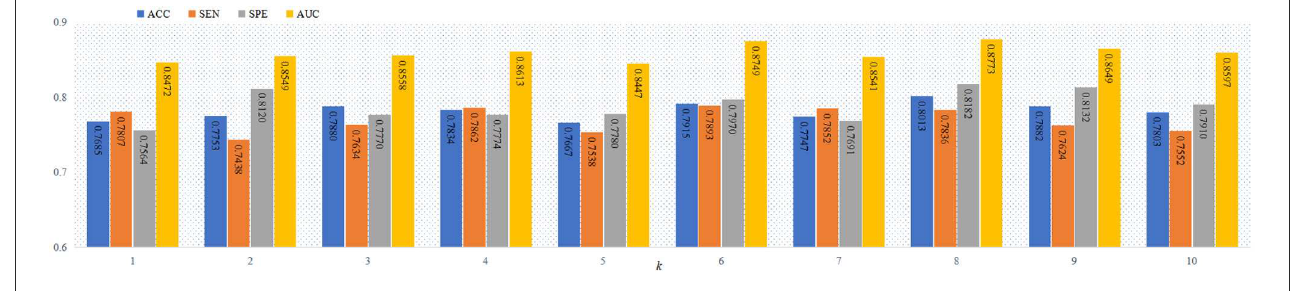
these seven methods. Here, the corresponding parametric values are λ = 2 − 2 for PC Sparsity and PC Sparsity +, λ 1 = 2 3 , λ 2 = 2 2 for M-PC and M-PC+, and λ = 2 − 1 for our